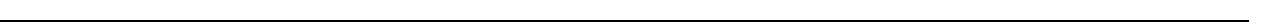
Fig. 2 Characterizing deliberation and foraging behaviors. a , b Example of X – Y locations of a mouse ’ s path trajectory in the offer zone over time during a single trial. a Skip decision for a high delay offer. The mouse initially oriented toward entering (right) then ultimately re-oriented to skip (left). Wait-zone threshold minus offer captures the relative subjective value of the offer. Negative value denotes an economically unfavorable offer. b Enter decision for positively valued offer; rapid without re-orientations. Reaction time ( c ) and VTE ( d ) behavior was higher for skip compared to enter decisions and only increased in more-preferred restaurants for skip decisions (KW tests, * P < 0.0001). e Mice were more likely to skip negatively valued offers the more they displayed VTE behavior. Vertical dashed line indicates the amount of VTE required to skip these offers 50% of the time. f Mice were more likely to enter these offers in higher-preferred restaurants, entering more than skipping in only the most-preferred restaurant (KW and Sign tests, * P < 0.0001). g Amount of VTE required to reliably skip these offers was higher in more-preferred restaurants (KW tests, * P < 0.0001). h , i Example of path trajectory in the offer and wait zones. h Rapidly entering then earning a positively valued offer. i Rapidly entering then quitting a negatively valued offer. j , k Cumulative probability distribution of offer zone time ( j ) and VTE ( k ) for skips and enters split by offer value. Both types of enter decisions were rapid compared to skips (Kolmogorov – Smirnov (KS) tests, * P < 0.05) and indistinguishable from each other (KS tests, not signi fi cant, n.s., P > 0.05). l , m Majority of quits took place for negatively valued offers and while time left was still greater than wait zone thresholds ( l ), despite taking longer to quit in more-preferred restaurants ( m , KW-D tests, * P < 0.0001). n Although mice were more likely to quit negatively valued offers while the amount of time left was still above wait zone thresholds in all restaurants, they were less capable of doing so in more-preferred restaurants (KW and Sign tests, * P < 0.0001). Error bars. ± 1